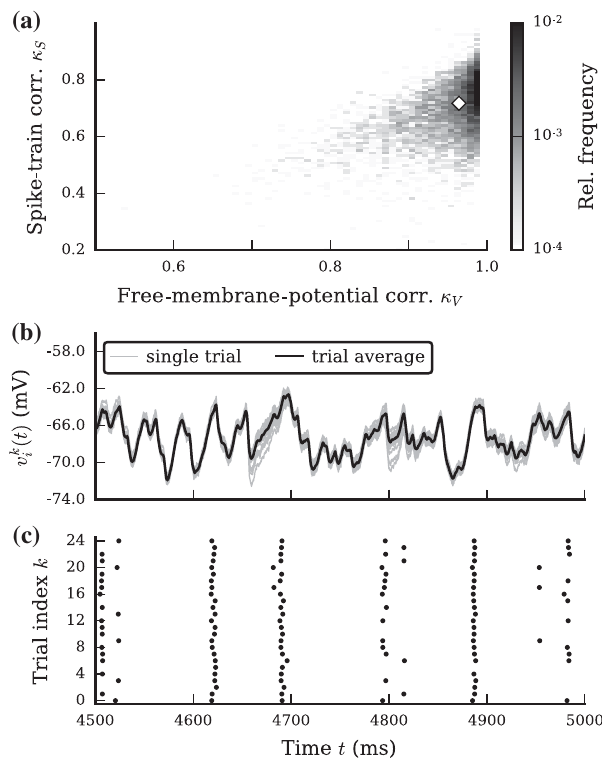
FIG. 3. Reproducibility of free membrane potentials and spik- ing activity in the FB case. (a) Low-frequency coherence κ V replay and κ of free membrane potentials v k ð t Þ and v l ð t Þ and binned S i i spike trains s k ð t Þ and s l ð t Þ , respectively, for each neuron i i i averaged over L ¼ 25 trials k , l , with k ≠ l , for M ¼ 50 different network realizations. The diamond marks the average across all 0 . 96 , κ 0 . 72 ). neurons i and M network realizations ( κ V ¼ S ¼ (b) Free single-trial membrane potentials v k ð t Þ (gray lines) and P i L v k average over trials ð 1 =L Þ ð t Þ (black line), and (c) spike i k ¼ 1 t Þ of a single neuron i for L ¼ 25 identical trials. The density ξ i ð selected neuron i has membrane-potential coherence and spike- train coherence closest to the diamond in